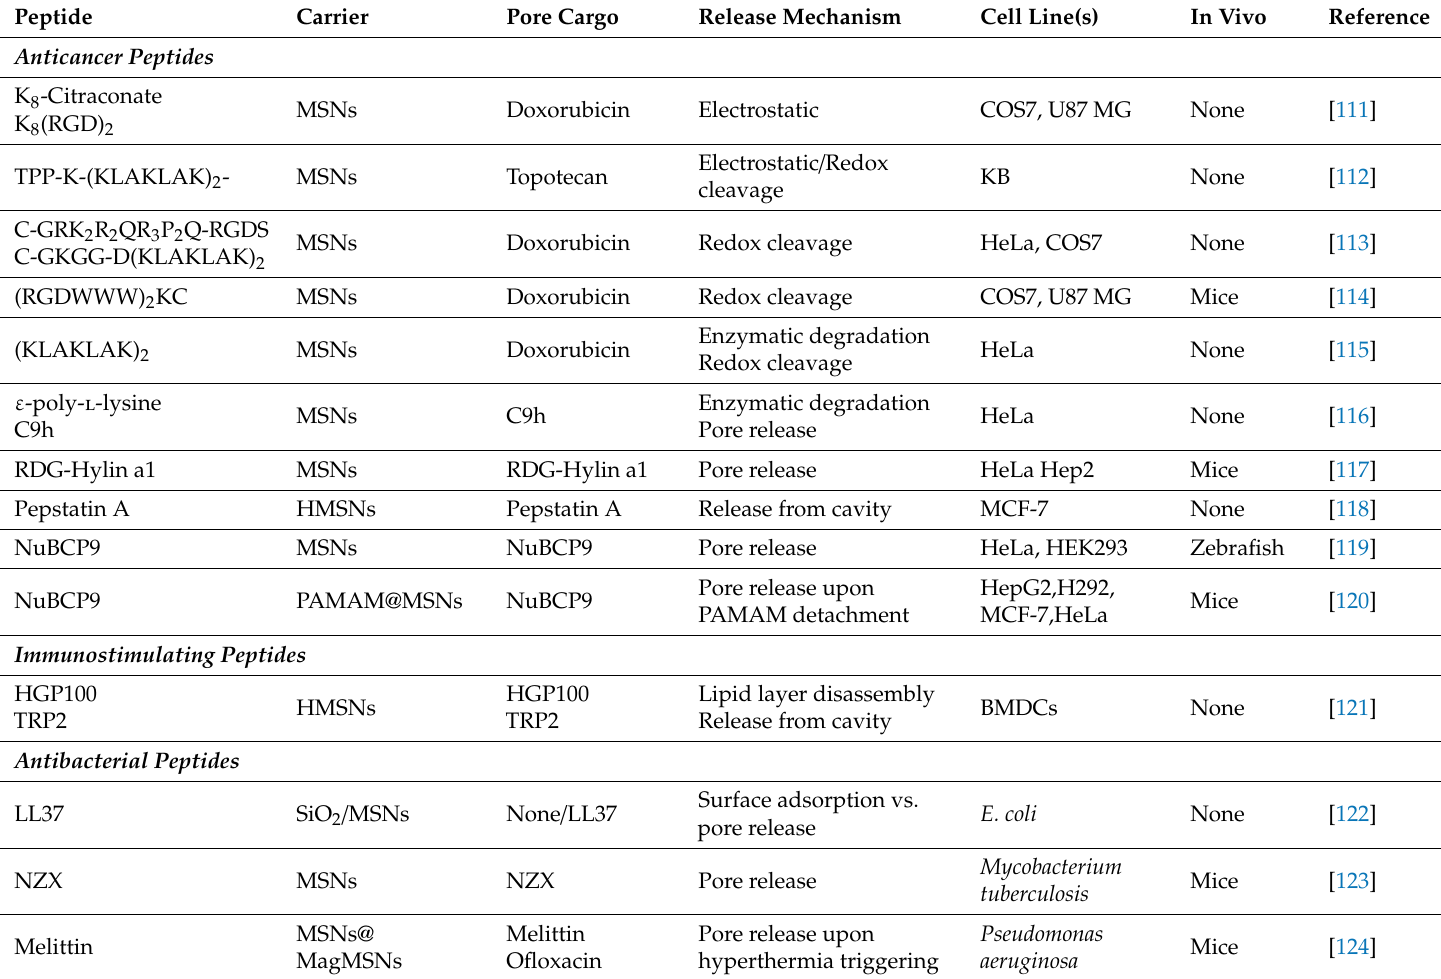
Table 2. Examples of di ff erent types of therapeutic peptides delivered by mesoporous silica-based nanocarriers.